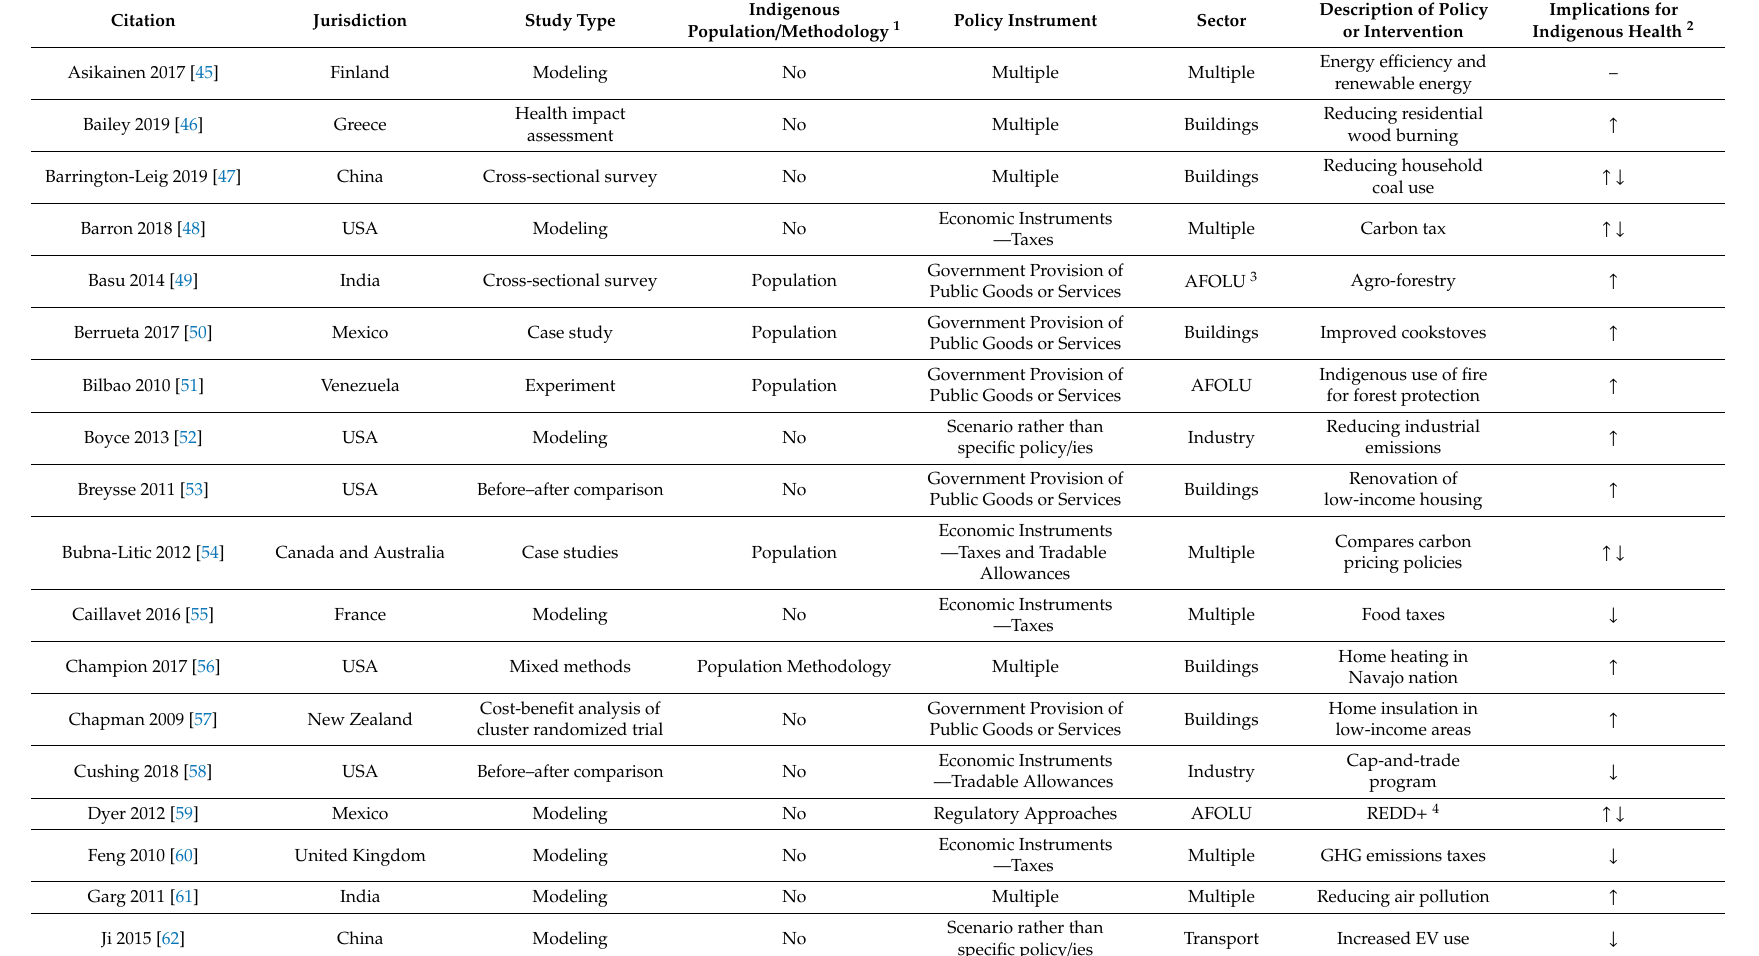
Table 1. Details of included